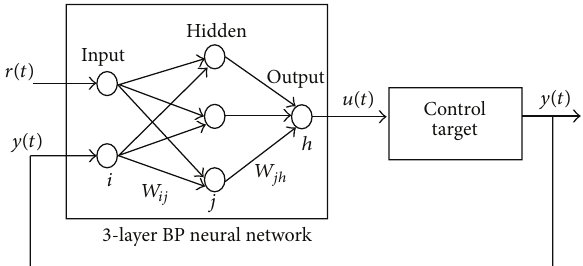
Figure 4: Schematic diagram of a BP NN controller in feedback loop.